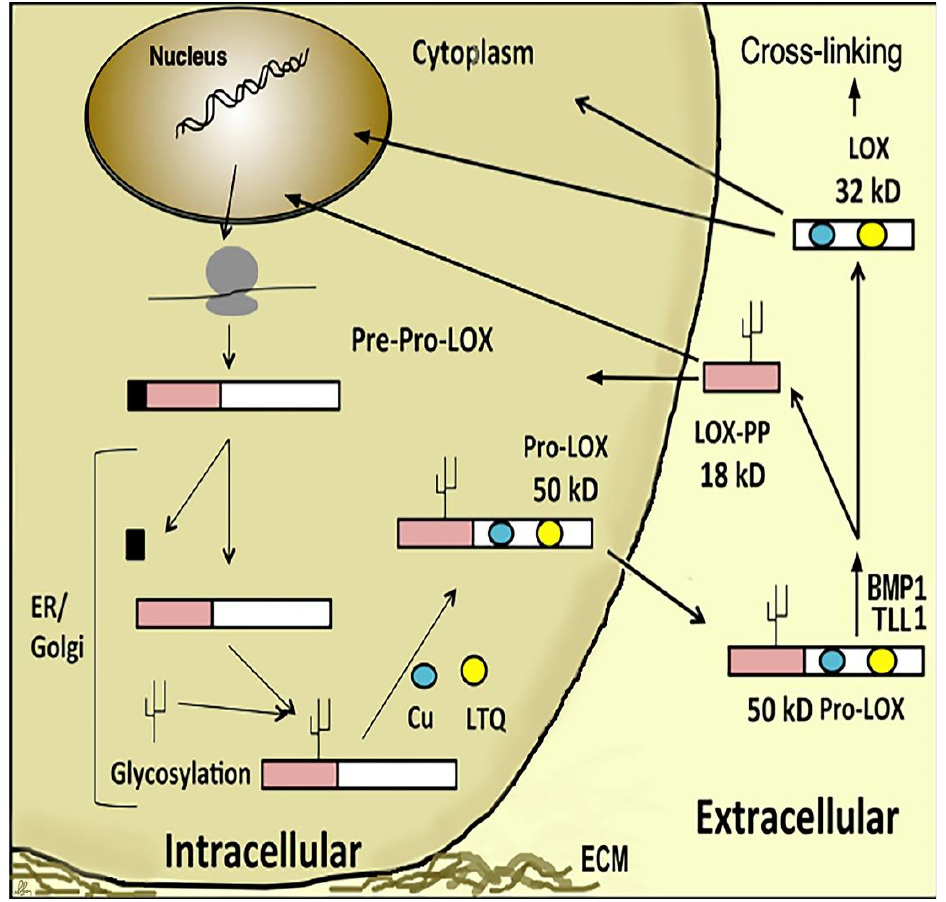
Figure 1. Diagram illustrating LOX and LOX-PP biogenesis. LOX is synthesized as a 50 kD inactive Pro-LOX and processed extracellularly by proteolytic cleavage into a functional 32 kD LOX enzyme and an 18 kD propeptide (LOX-PP). Additional proteolytic processing sites of Pro-LOX have recently been identified. LOX-PP has both intracellular and extracellular targets.